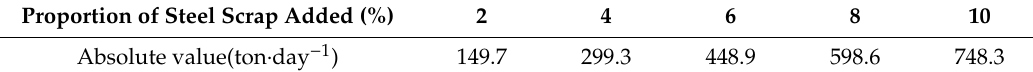
Table 6. Amount of steel scrap added.